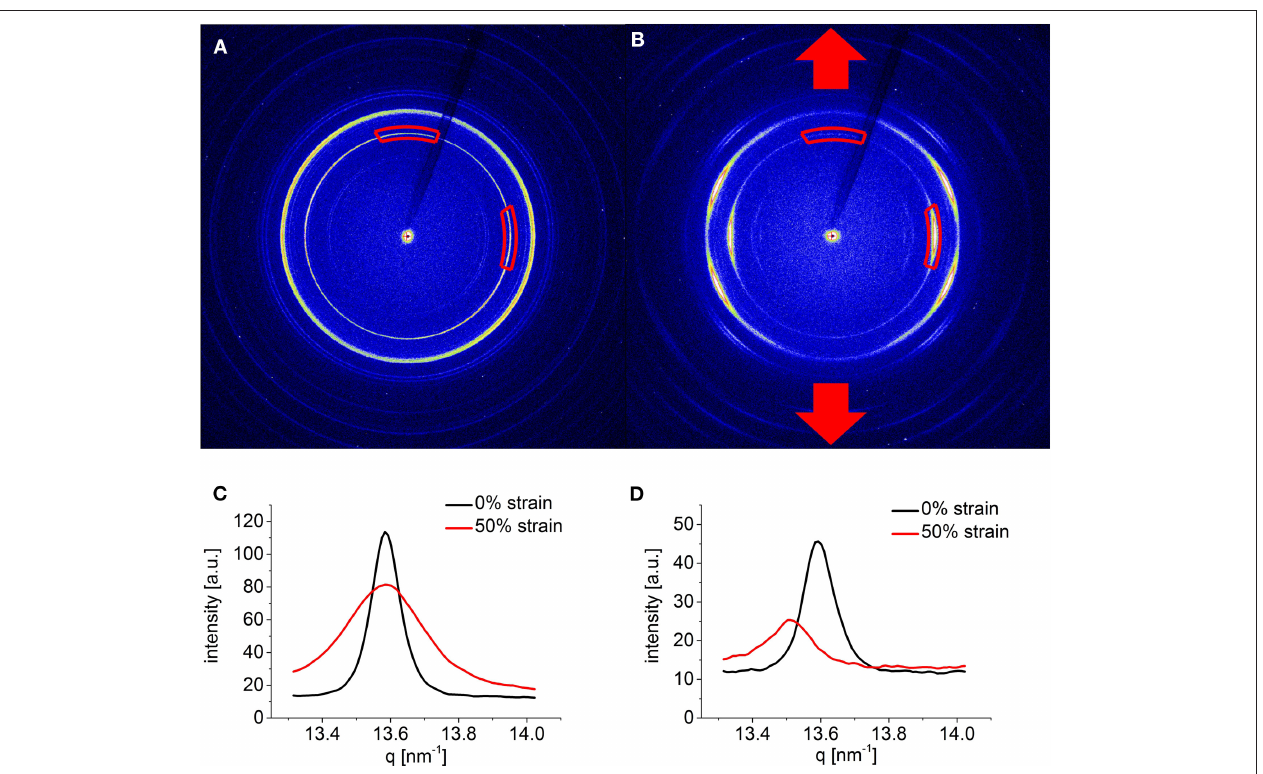
FIGURE 4 | Two-dimensional diffraction patterns of non-filled PEO (A) before and (B) at 50% tensile strain. Before applied tensile stress, only weak textures as a result of sample preparation were visible in the Debye Scherrer rings, whereas the rings at 50% strain show a distinct texture. (C) Radial profiles before and at 50% tensile strain of the (120) signal with a c-axis crystallite orientation in tensile direction. A broadening of the signal appeared at 50% tensile strain. (D) Radial profiles before and at 50% tensile strain of the (120) signal with a c-axis crystallite orientation perpendicular to the tensile direction. A peak shift to lower q values appeared after applied tensile